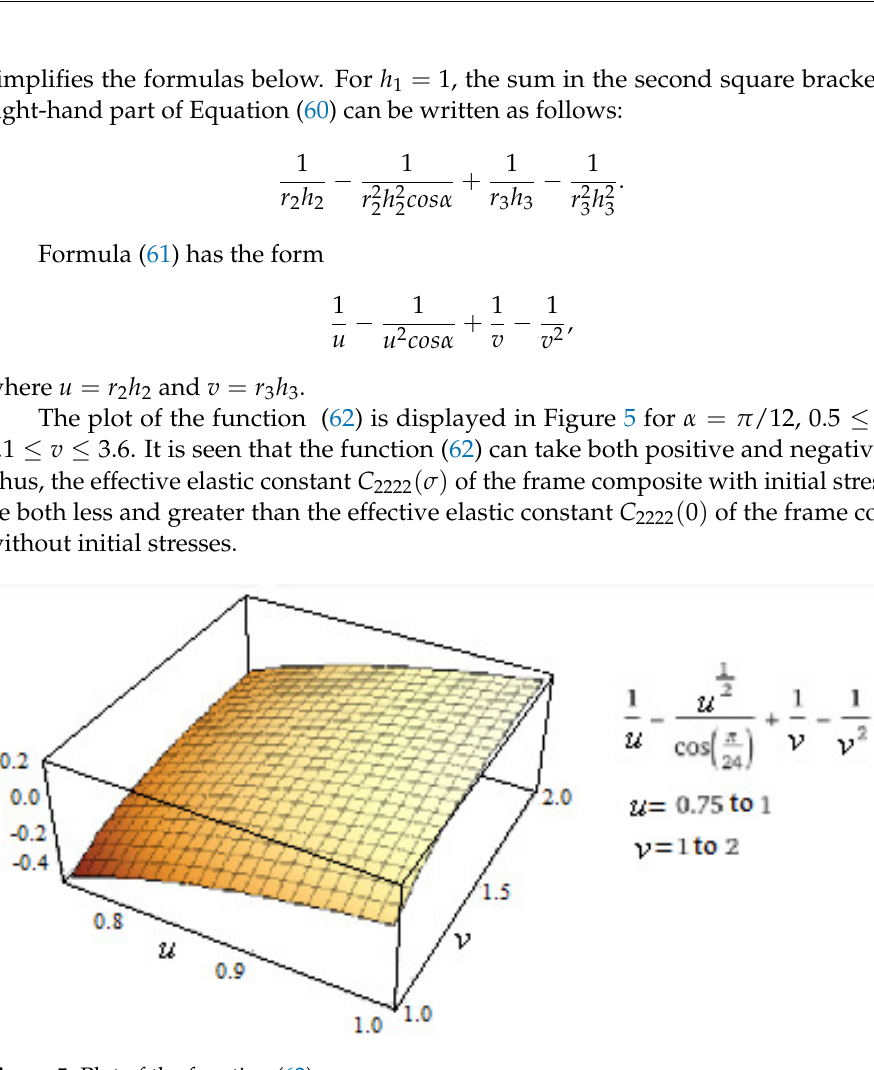
Figure 5. Plot of the function